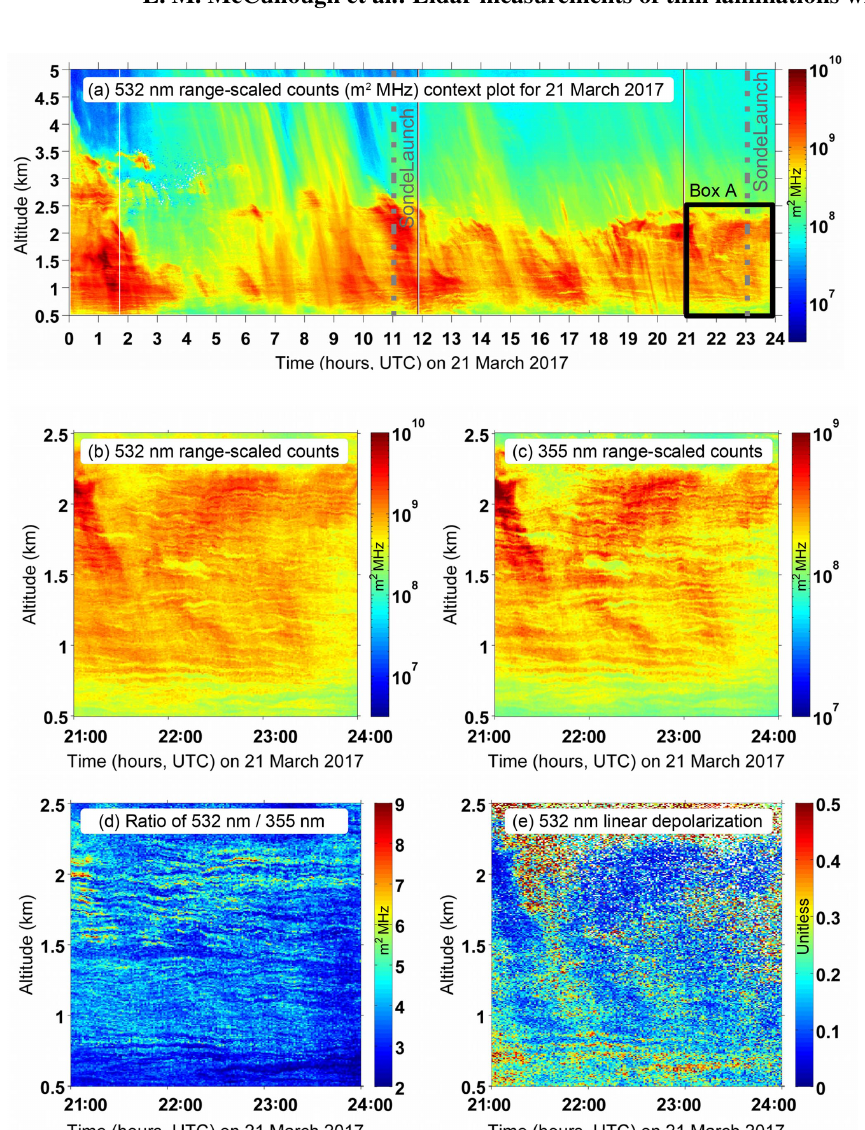
Figure 4. Measurements from 21 March 2017. Clouds persisted for the majority of the day with thin layers visible in all clouds below 3km altitude. Fall streaks indicative of precipitating particles are frequently present. This instance of laminated cloud lasted in excess of 42h, beginning on the previous day and ending on the following day. Panel (a) is a context plot of 532nm range-scaled photocounts. Panels (b, c, d, e) are detailed plots for the region indicated by the black Box A of (a) . Panels (b, c) are 532 and 355nm range-scaled photocounts, respectively; panel (d) is the ratio of 532 / 355nm photocounts; panel (e) is the 532nm linear depolarization